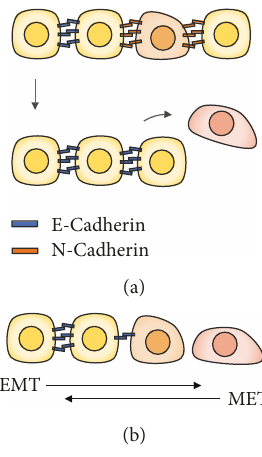
Figure 2: Cadherin involvement in tissue morphogenesis. (a) Cell sorting based on di ff erential expression of distinct cadherins. (b) Epithelial-mesenchymal transition (EMC) and its reverse (MET), an example of self-assembly capacity mediated by di ff erential cadherin expression and